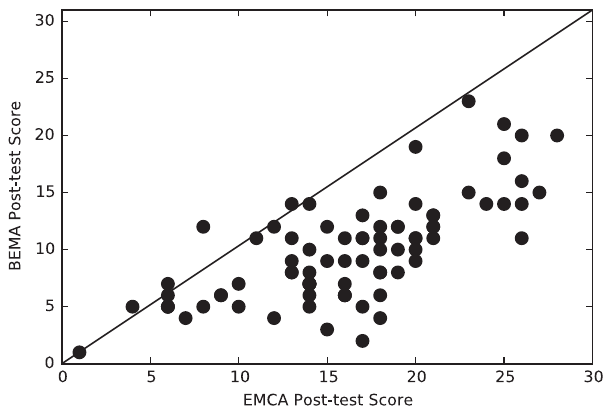
FIG. 10. BEMA scores versus EMCA scores. A Spearman rank correlation test analysis shows that there is a statistically significant correlation between the BEMA and EMCA scores for the 2017